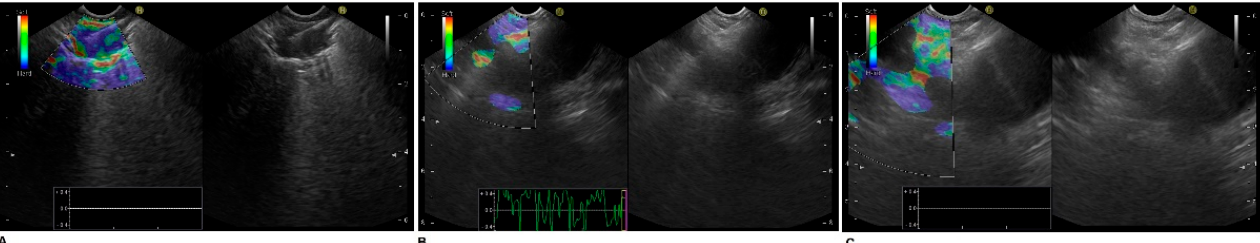
Figure 1. EUS-FNA lung cancer staging procedure with elastography: ( A ) Right lower lobe NSCLC. ( B ) Station 7. ( C ) Station 5.